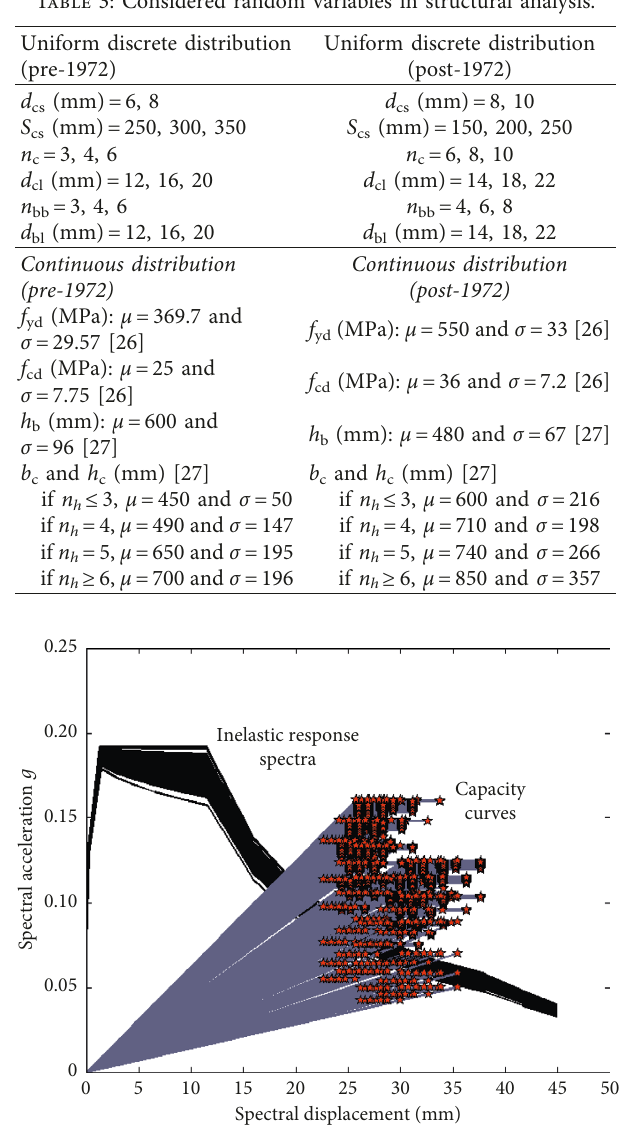
Figure 8: Inelastic capacity curve and inelastic response demand spectrum for all the realizations of the example building (no. 39) at T R � 101 years and a g � 0.063g.